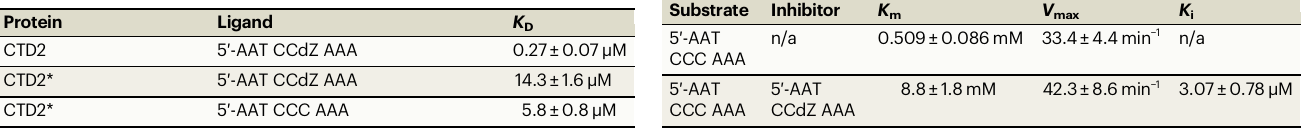
Table 2 | Enzymatic parameters for A3G